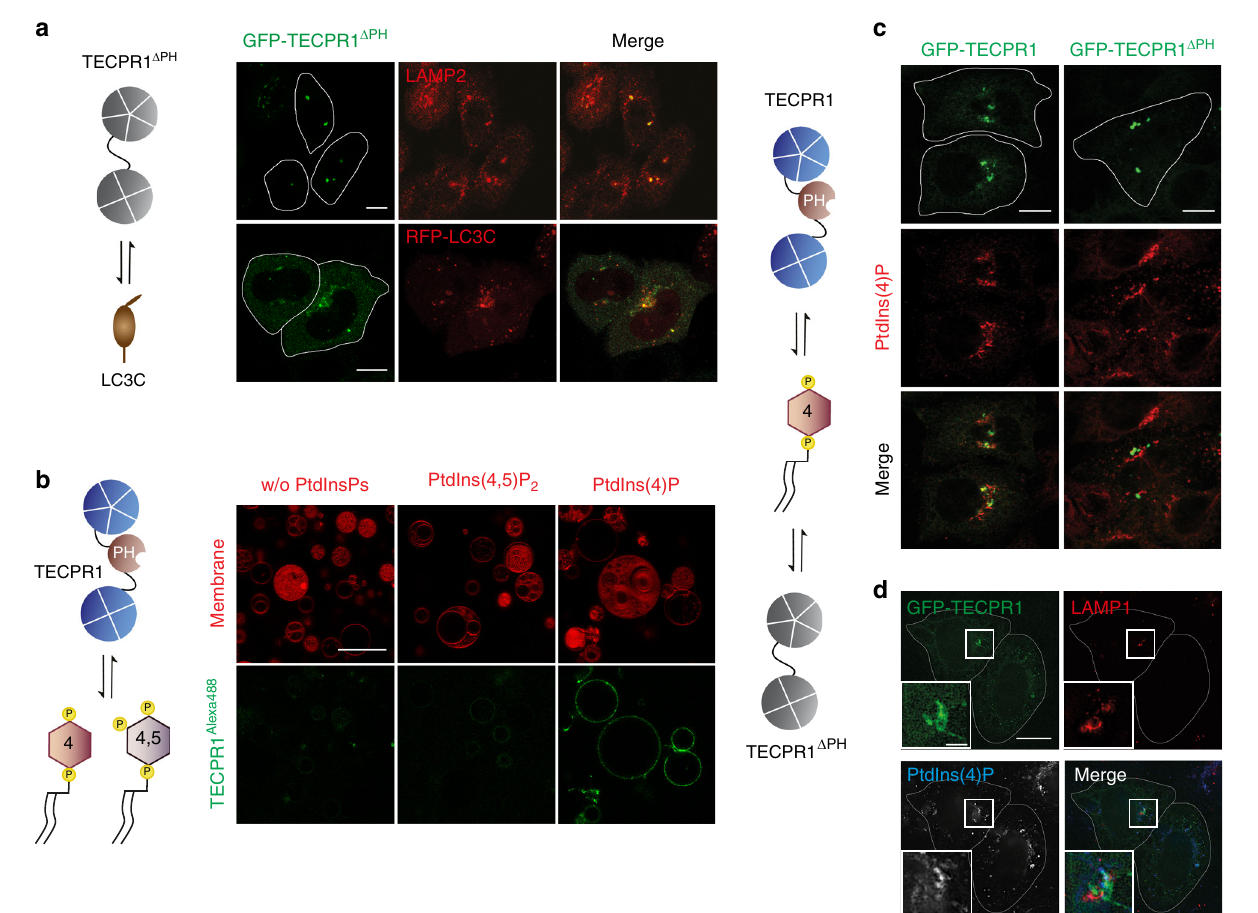
Fig. 4 TECPR1 selectively binds PtdIns(4)P. a Colocalization of GFP-TECPR1 Δ PH with RFP-LC3C or immunostained LAMP2. Scale bars, 10 µ m. b Binding of Alexa488-labeled TECPR1 to GUVs containing indicated PtdInsP. Scale bars, 20 µ m. See also Supplementary Fig. 4b. c Colocalization of GFP-TECPR1 or GFP-TECPR1 Δ PH with immunostained PtdIns(4)P in TECPR1 KO cells. Scale bars, 10 µ m. d Structured-illumination microscopy of TECPR1 KO cells expressing GFP-TECPR1 that were stained for LAMP1 and PtdIns(4)P. Scale bar, 10 µ m, insets, 2.5 µ